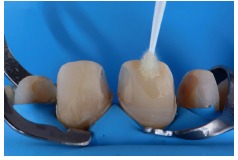
Bond application.